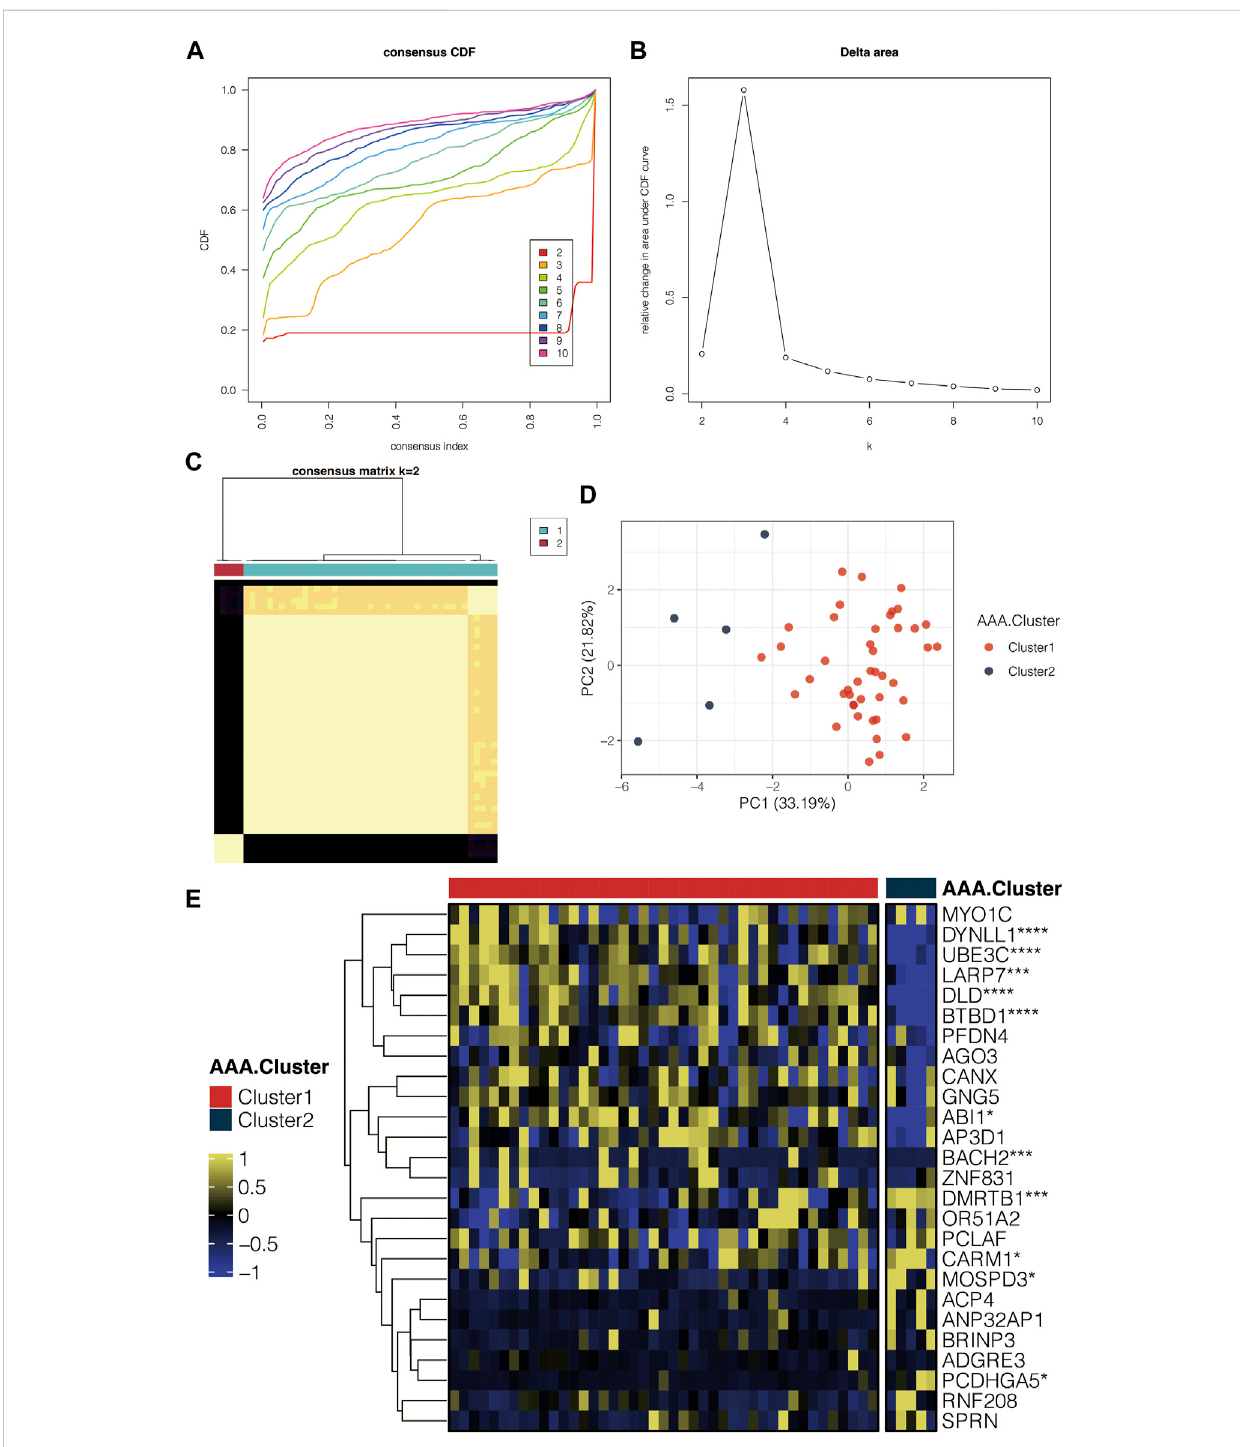
FIGURE 5 Identi fi cation of the AAA-related clusters. (A) Consensus CDF curves in GSE98278. (B) Delta area in GSE98278. (C) Consensus matrix with k = 2 in GSE98278. (D) PCA of the AAA-related clusters in GSE98278. (E) Heatmap for the AAA-related genes in the AAA-related clusters in